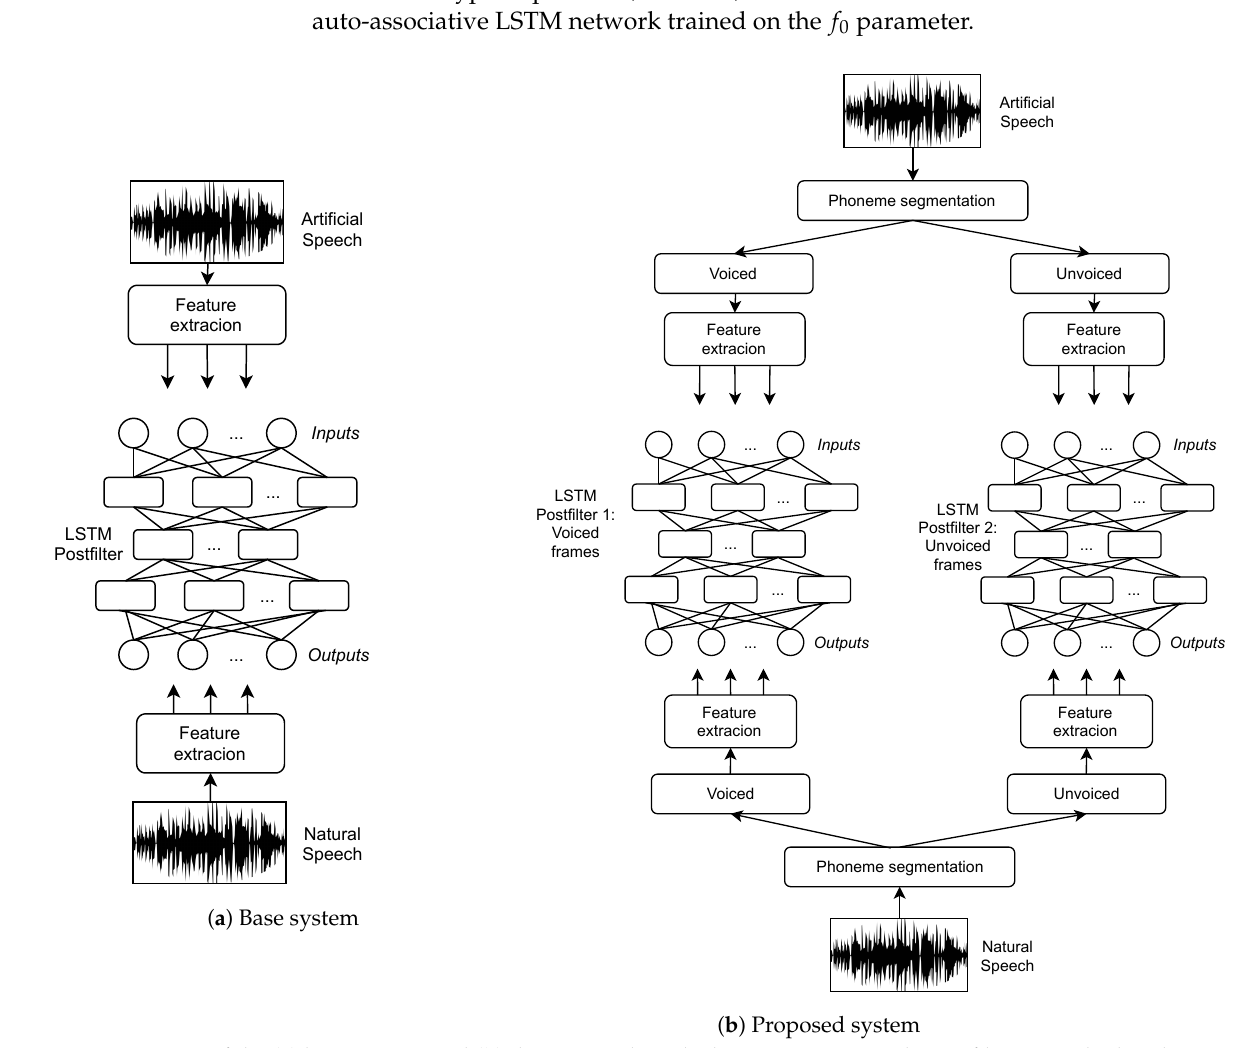
Figure 2. Comparison of the ( a ) base system and ( b ) the proposal. In the base system, a single postfilter is applied to the whole utterance, regardless of the nature of the individual sounds. In our proposal, the postfilter is applied selectively, by discriminating the unvoiced/voiced nature of the